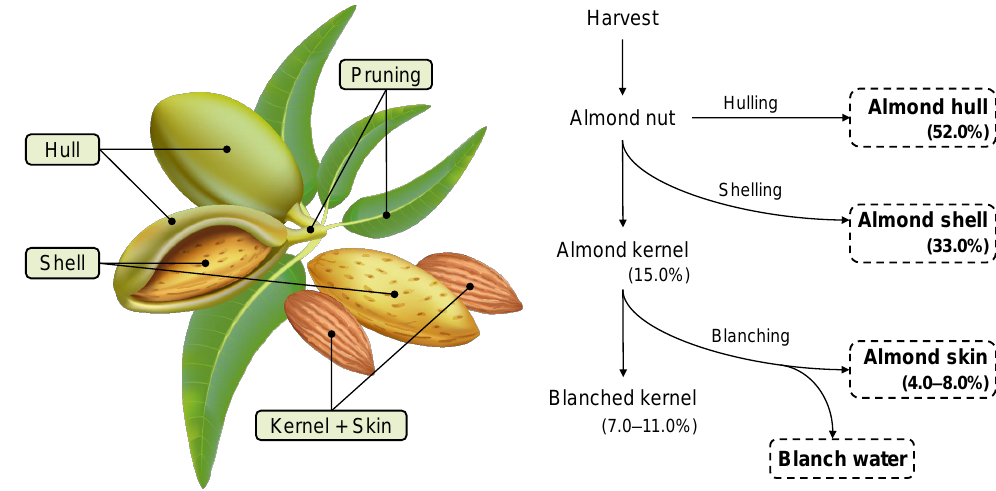
Figure 2. Parts of almond fruit ( left ) and almond processing by-products ( right